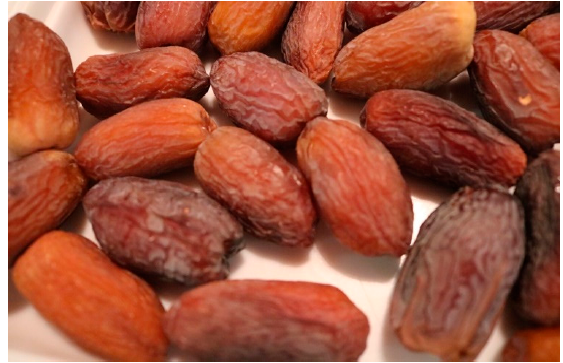
Figure 15. Sample of Al-majdool dates. Figure 16. Sample of Al-masyihia dates.